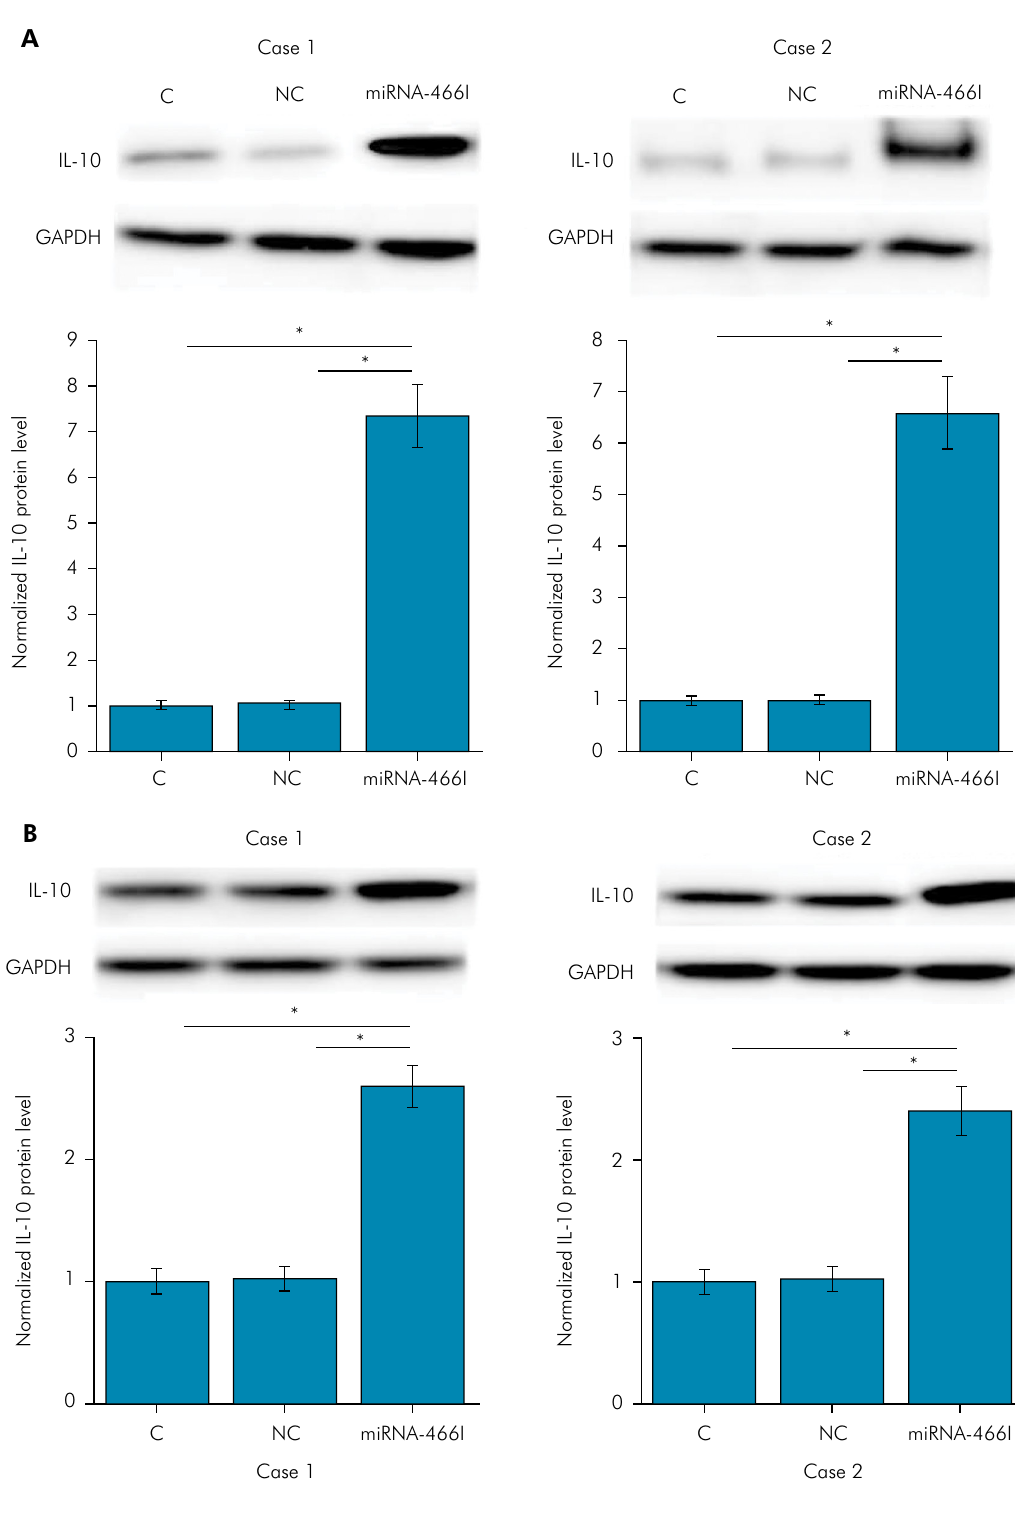
Figure 3. Effects of microRNA-466l overexpression on IL-10 expression in two cultures of PDLSCs derived from periodontitis-affected teeth (a) and two cultures of PDLSCs derived from healthy teeth